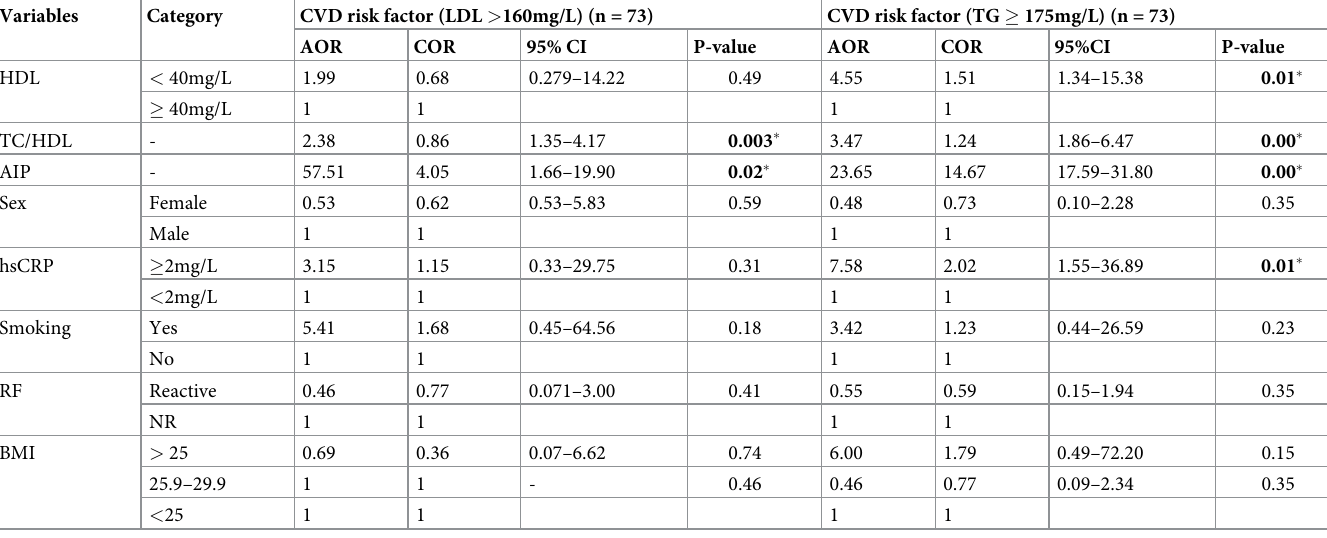
Table 3. Multiple logistic regression of atherogenic indices and demographic data with cardiovascular risk